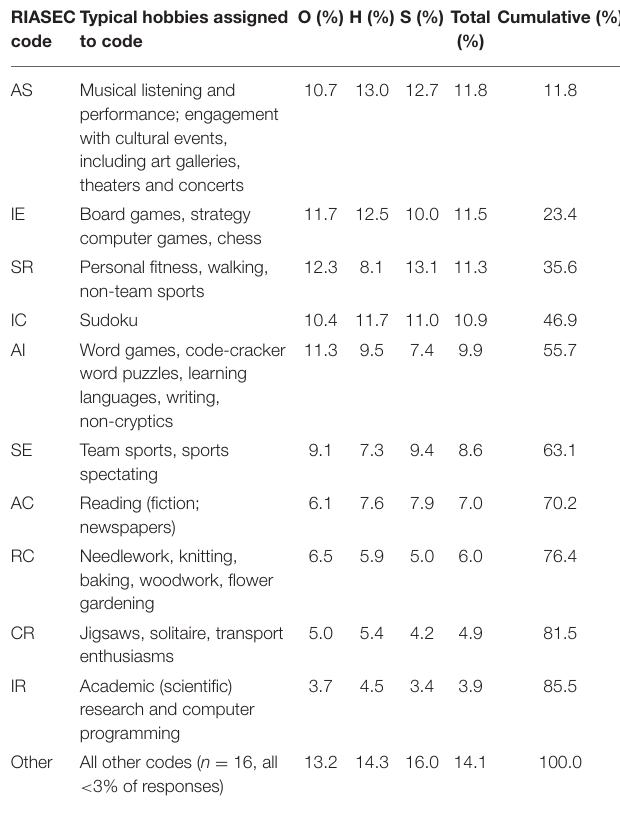
TABLE 10 | Distribution of hobby responses among RIASEC codes, by